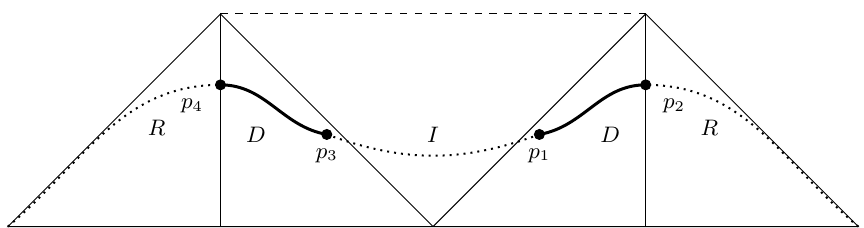
Figure 3 . The generalized entropy for points p 2 and p 4 at the boundaries with QES’s at points p 1 and p 3 in the bulk involves calculating the entropy of disjoint intervals as